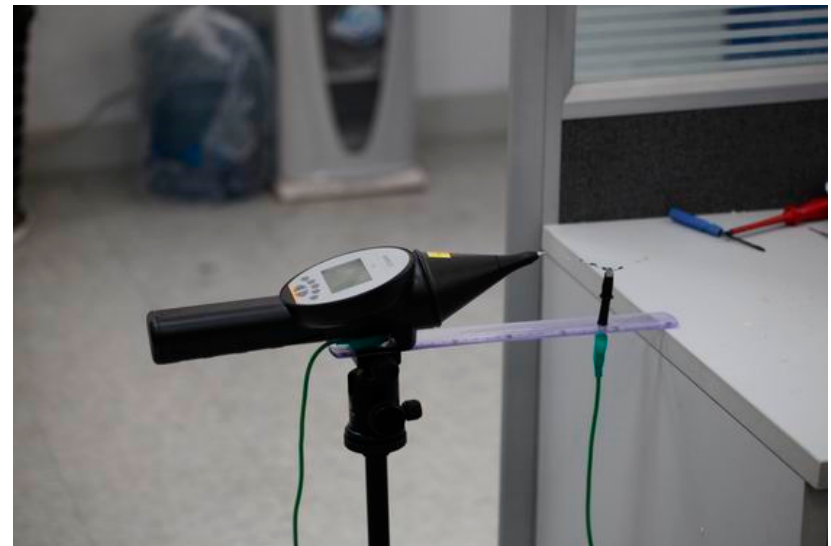
Figure 11. The PD simulator “EM TEST DITO”.